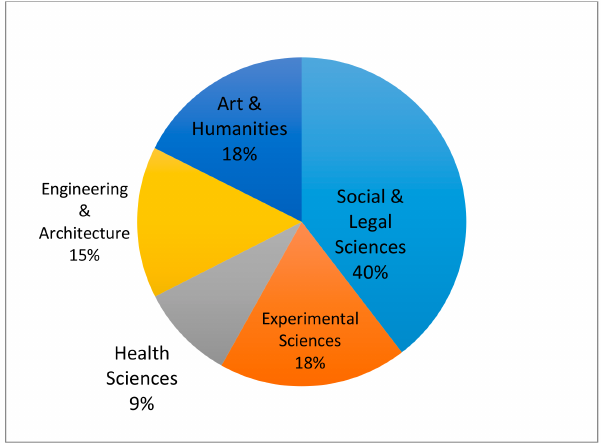
Figure 7. Area of knowledge.